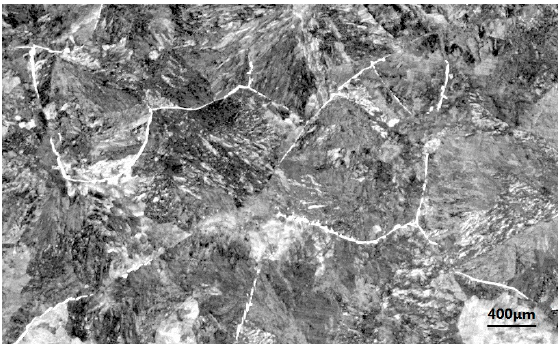
Figure 6. Micrographs showing macrostructure of center-equiaxed grains.